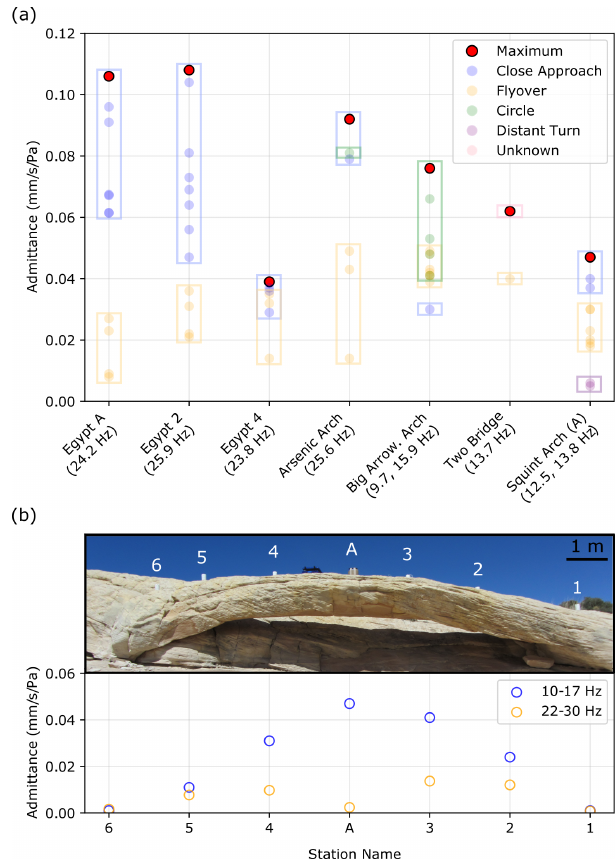
Figure 4. (a) Admittance values for different maneuvers at all study sites. Landform natural frequency excited is noted in parentheses beneath each label. (b) Maximum admittance values at different locations on Squint Arch. Numbers (nodal geophones) and letter (broadband seismometer) above the arch indicate station